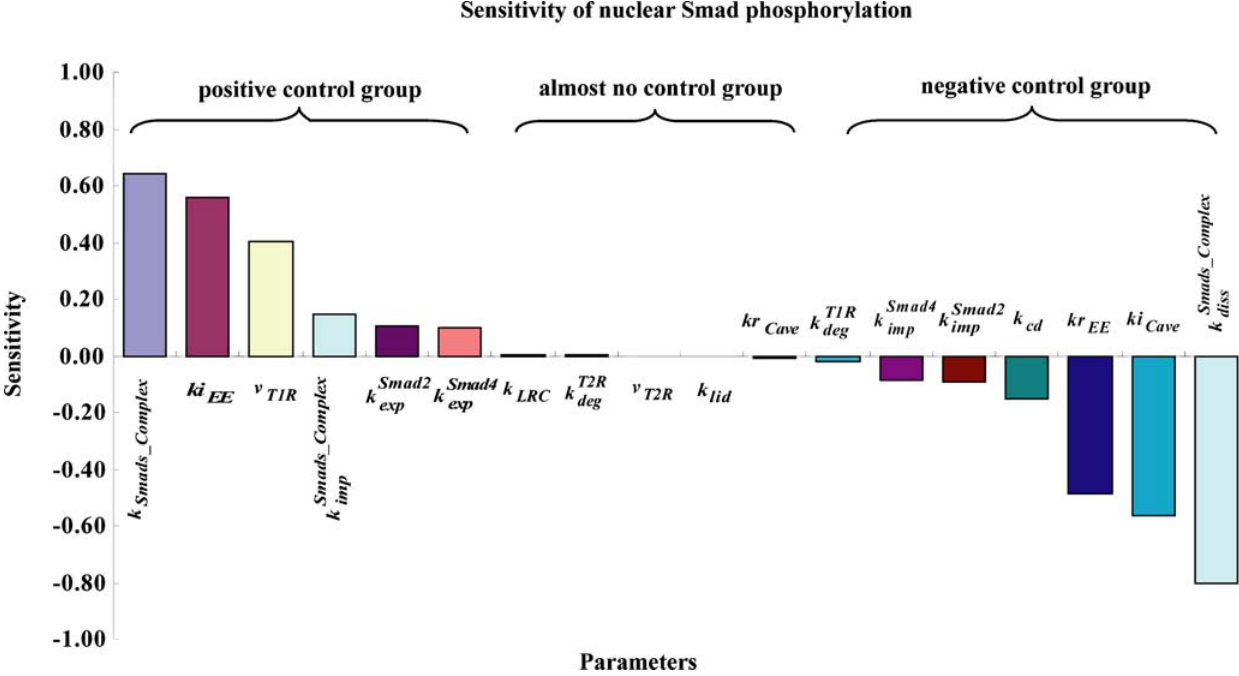
Figure 5. Sensitivity analysis of the rate constants on nuclear Smad phosphorylation. The original values of the sensitivities are present Table S3 doi:10.1371/journal.pone.0000936.g005 PLoS ONE |